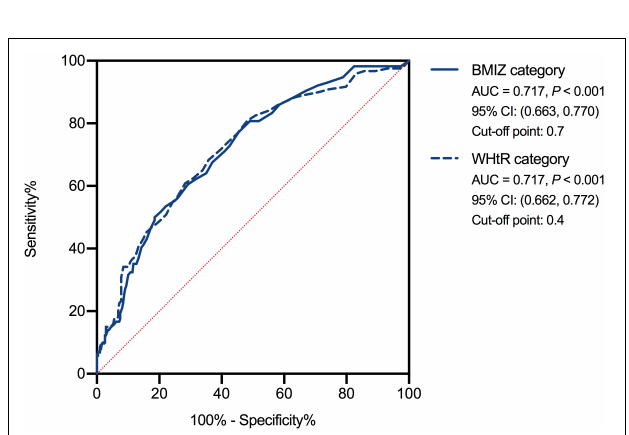
FIGURE 5 | The receiver operating characteristic curve of food addiction for normal-weight/underweight and excessive weight groups. BMIZ, body mass index Z score; WHtR, waist-to-height